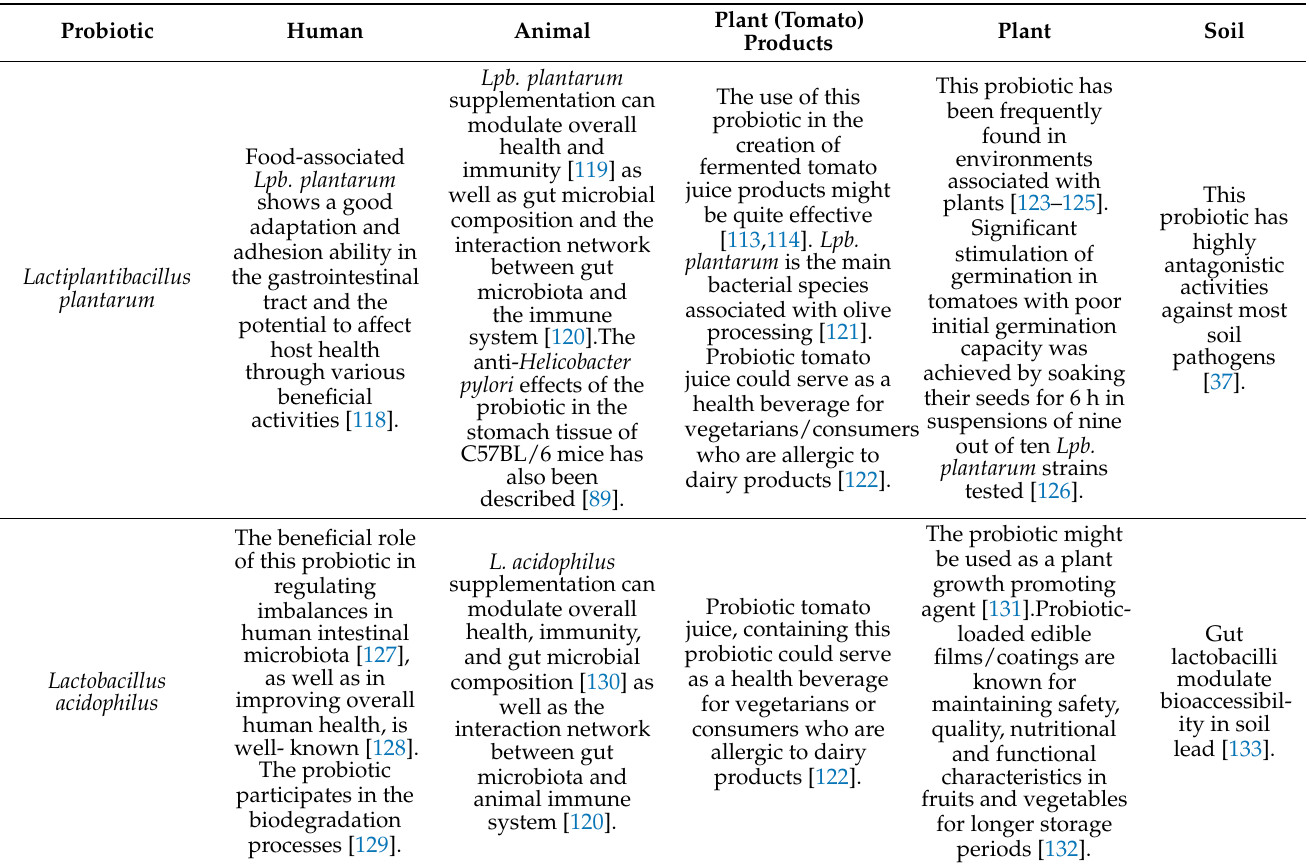
Table 2. Effects of lactobacilli